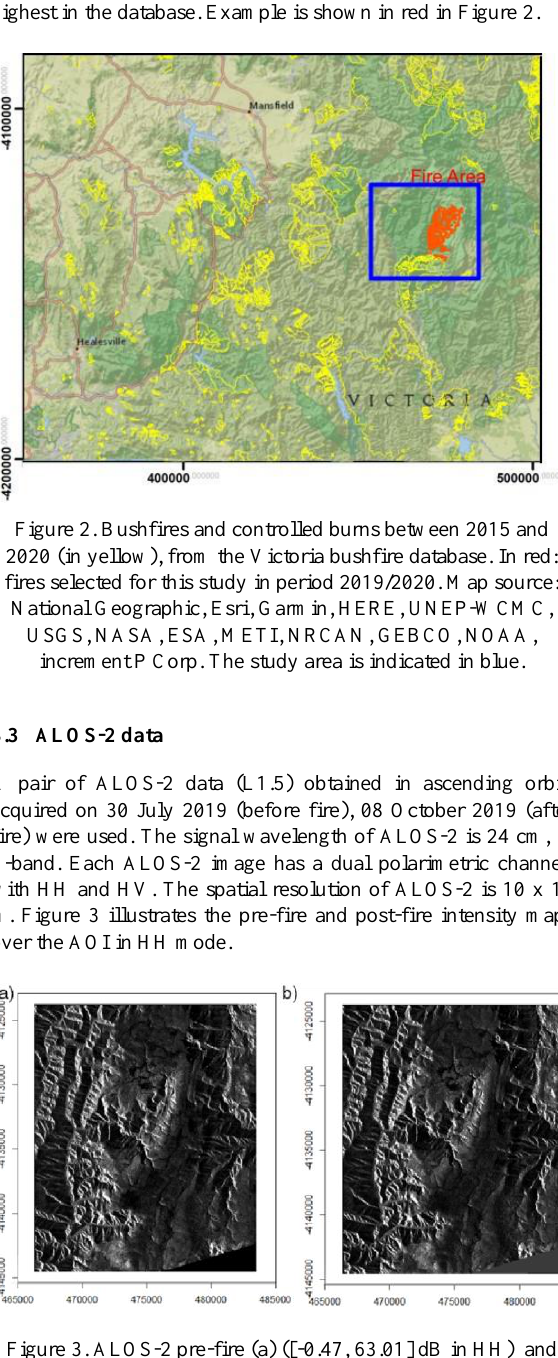
Figure 3. ALOS-2 pre-fire (a) ([-0.47, 63.01] dB in HH) and post-fire (b) ([-0.44, 47.13] dB in HH) intensity images covering the area of bushfires,